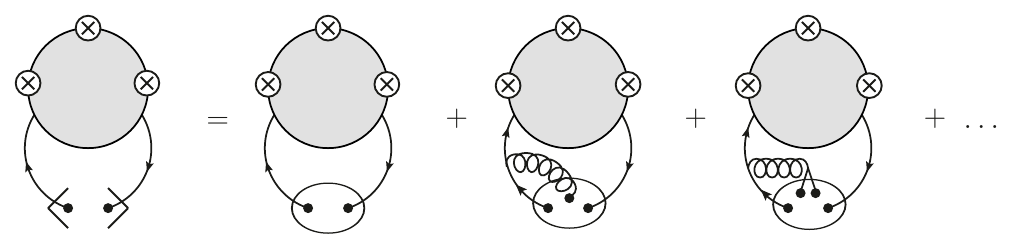
Figure 1. A graphical illustration of the propagation formula (3.9a). The black line stands for the quark line and the bold dot on its end represents the quark (cid:12)eld that goes between the vacuum states. The curly line stands for the gluon (cid:12)eld, if such line has a bold dot on its end, it represents the gluon (cid:12)eld that goes between the vacuum states. The symbol (cid:10) stands for insertion of the current and the grey blob means any possible couplings to other currents or the quark-gluon vertices. On the left-hand side, the brackets around the quark (cid:12)elds mean averaging over them according to the formula (3.9a), while on the right-hand side, the oval over the respective quark or gluon (cid:12)elds means a creation of the local condensates.